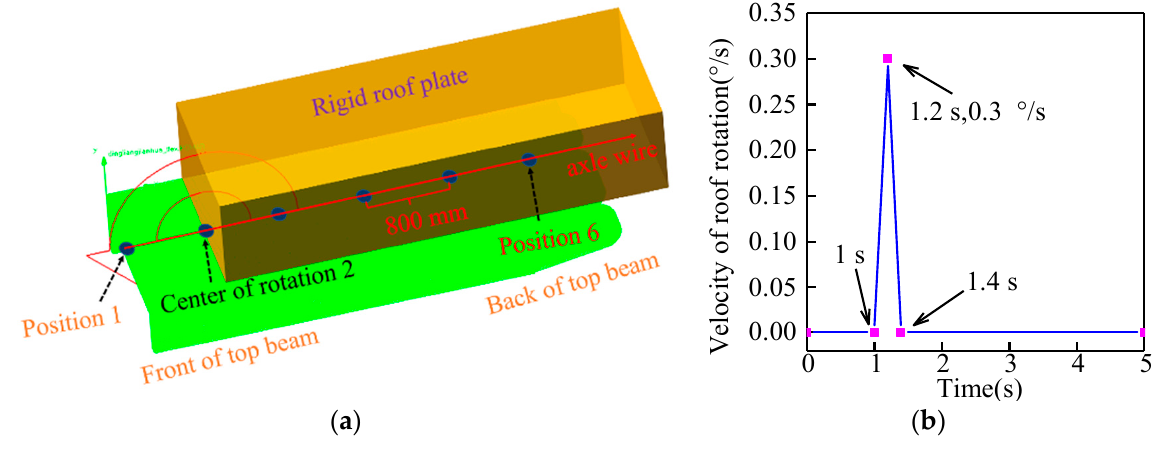
Figure 8. ( a ) Roof rotation position. ( b ) Velocity of roof rotation.